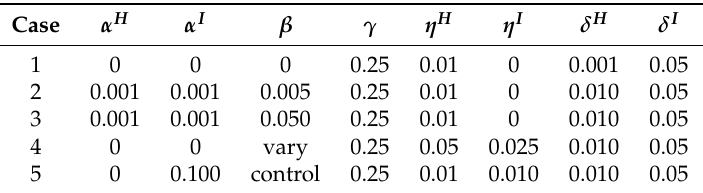
Table 1. Test cases used to evaluate the model.